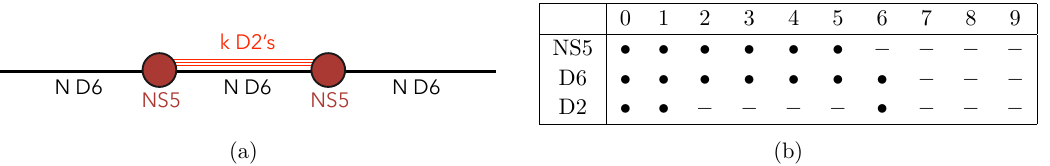
Figure 1. IIA brane system for 6d SU( N ) theory Higgsable to M-string